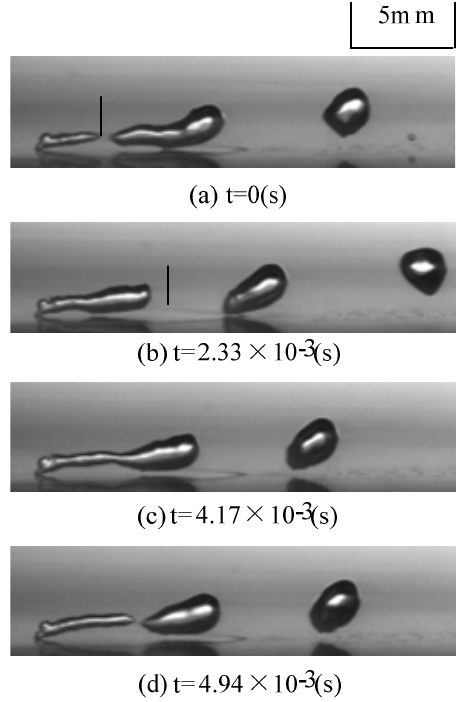
Fig. 7 Process of bubble growth and separation from the continuous jet (bubble separating from swelling at the front end of the jet) ( d m/s, v = 45 0